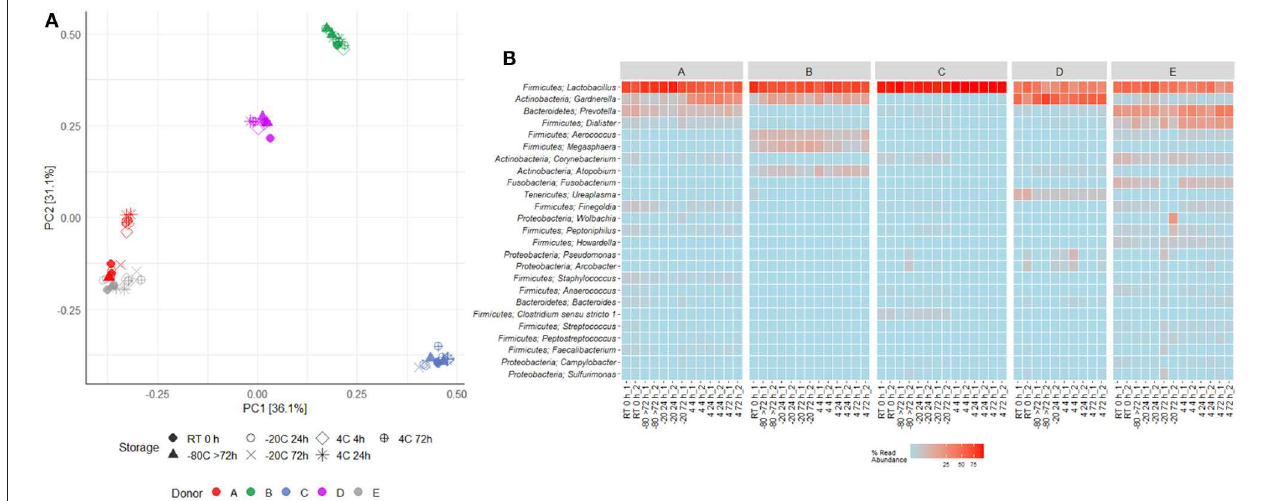
FIGURE 5 | Effects of storage temperature and duration on voided urinary microbiota beta-diversity. (A) Clustering of samples based on PCA of Hellinger transformed OTU abundances. (B) Heat map depicting the 25 most common OTUs in duplicates in different storage conditions for each donor (A–E). Each name consists of phylum followed by genus name. If no genus could be identified, the best taxonomic assignment is listed.